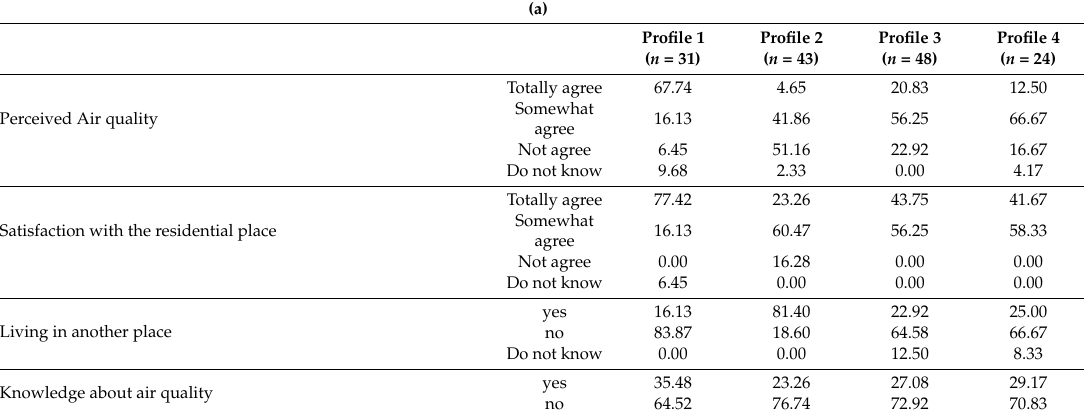
Table 3. ( a ) Descriptive statistics of perception, satisfaction and knowledge about air quality by the profile among the youngest (ages 18 to 29 years); ( b ) Descriptive statistics of